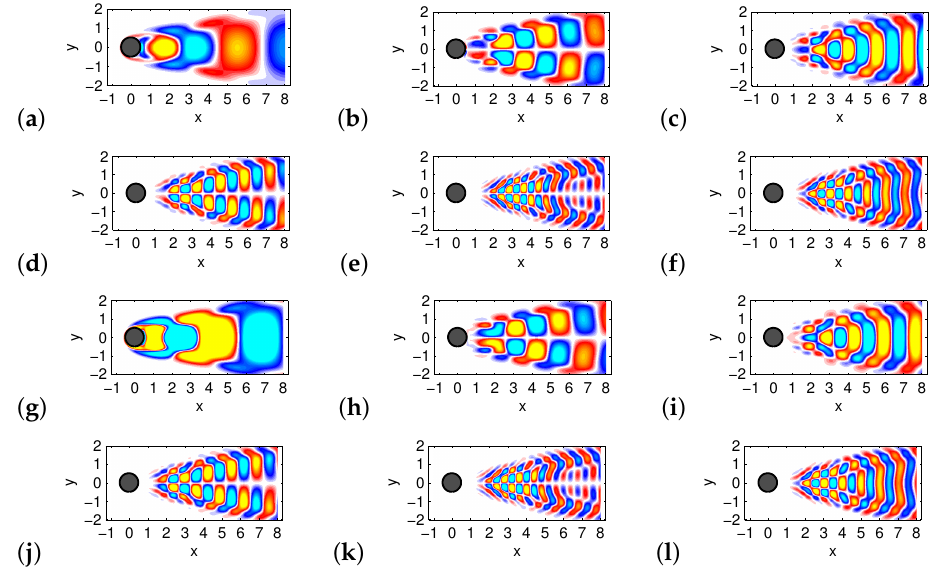
Figure 6. The first six DMD modes computed by Algorithm 1 are shown in ( a – f ). Corresponding DMD modes computed by Algorithm 2 are in ( g – l